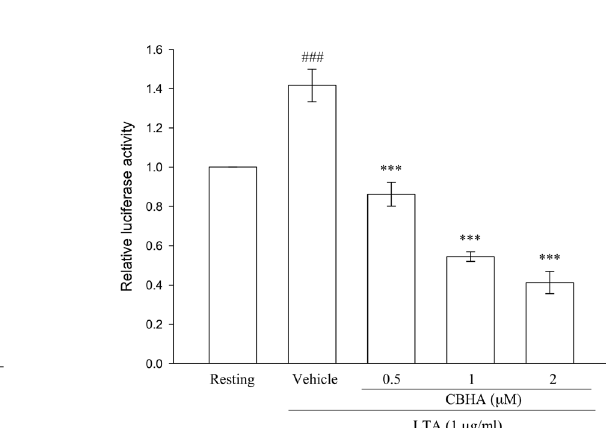
Figure 4. CBHA inhibits LTA-induced PAI-1 gene transcription in human PMCs. ( A ) MeT-5A cells were pretreated with the vehicle or the indicated concentrations of CBHA (0.5, 1 or 2 μ M), and then stimulated with LTA for 6 h. PAI-1 mRNA level was detected by RT-PCR analysis. Data were pooled from three independent experiments and expressed as average fold change (mean ± SEM) in the expression relative to resting or vehicle group. ( B ) MeT-5A cells were transfected with both the specific PAI-1 reporter plasmid (p800Luc) and internal plasmid (Renilla), then treated with different concentrations of CBHA, and followed by LTA stimulation for 24 h. The luciferase activity of PAI-1 reporter gene was assessed. Data were pooled from three independent experiments and expressed as average fold change (mean ± SEM) in the activity relative to resting or vehicle group. ## p < 0.01, ### p < 0.001 compared with the resting group; * p < 0.05, ** p < 0.01, *** p < 0.001 compared with the vehicle (DMSO) group.